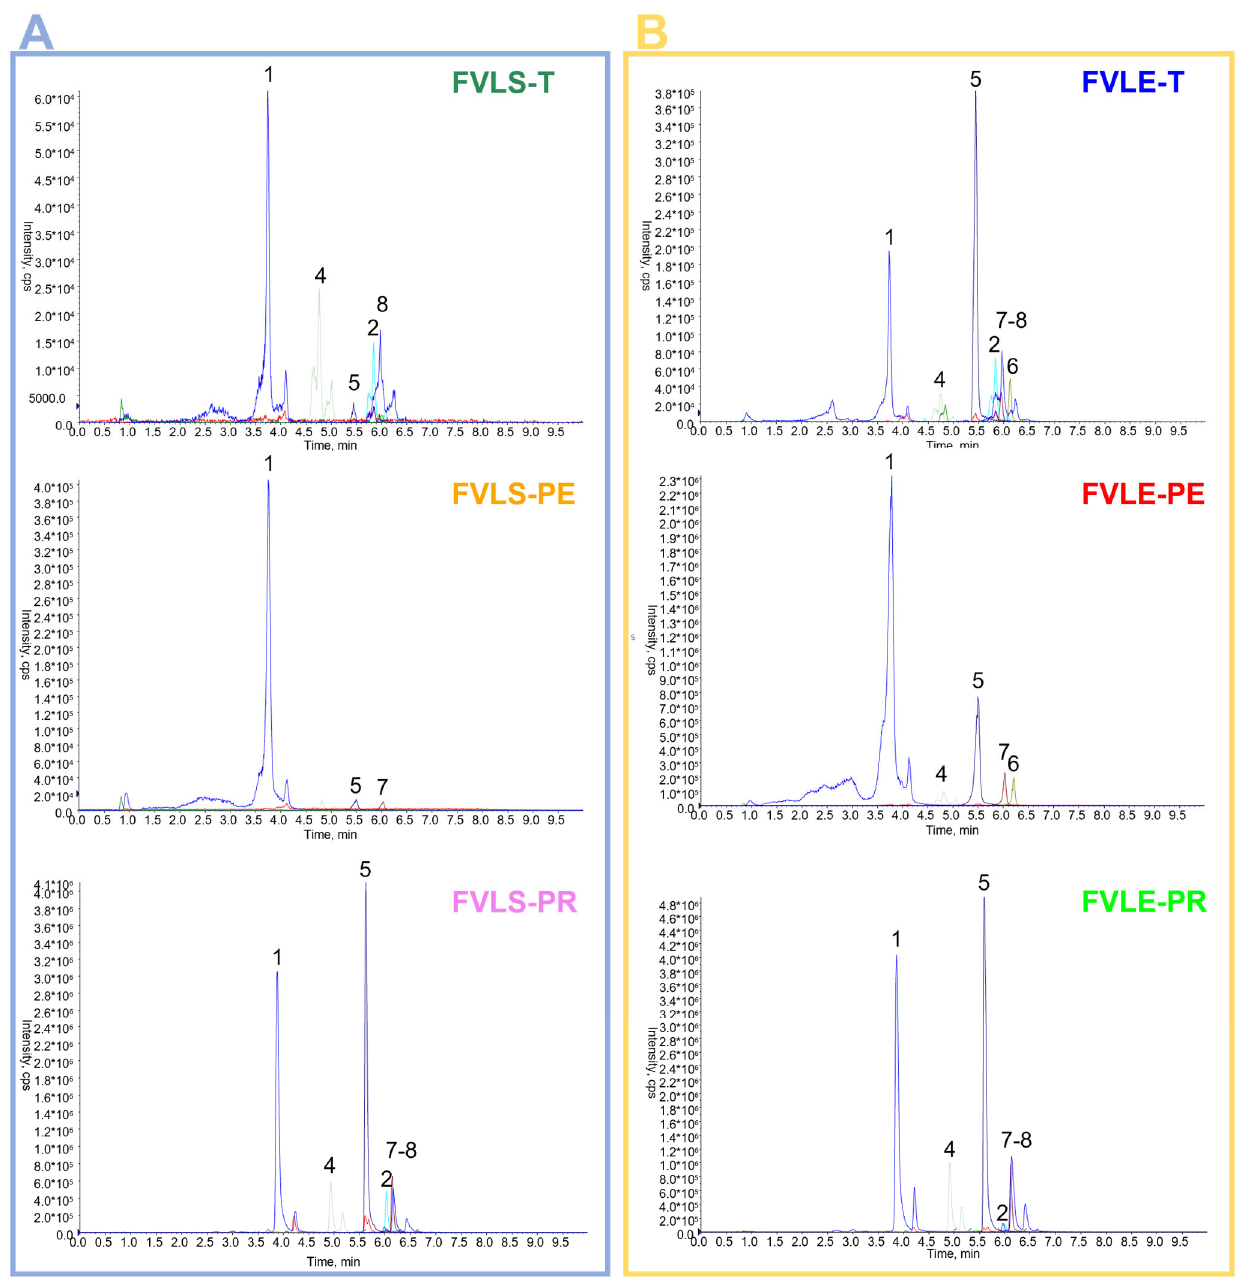
Figure 2. UHPLC-ESI-QTRAP-MS/MS profiles of hydroalcoholic extracts of the little stems ( A ) and leaves ( B ) of three varieties of F. vulgare. FVLS-T, Foeniculum vulgare little stem Tiziano variety; FVLS-PE, Foeniculum vulgare little stem Pegaso variety; FVLS-PR, Foeniculum vulgare little stem Preludio variety; FVLE-T, Foeniculum vulgare leaf Tiziano variety; FVLE-PE, Foeniculum vulgare leaf Pegaso variety; FVLE-PR, Foeniculum vulgare leaf Preludio variety.